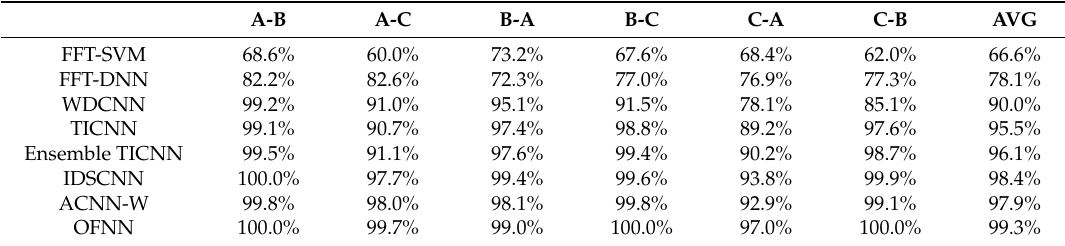
Table 5. Comparison of different